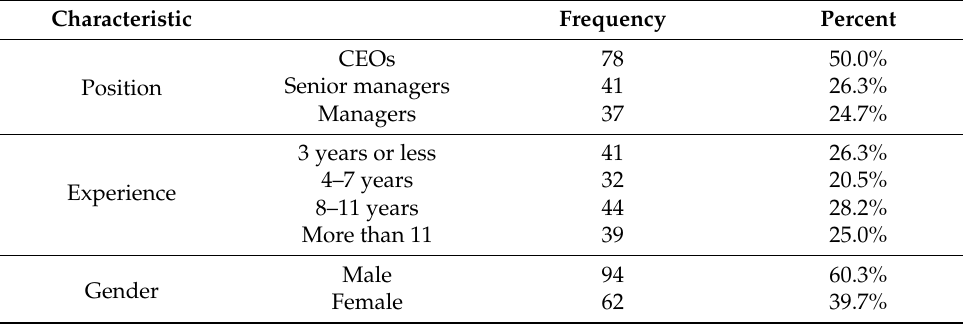
Table 2. Demographic